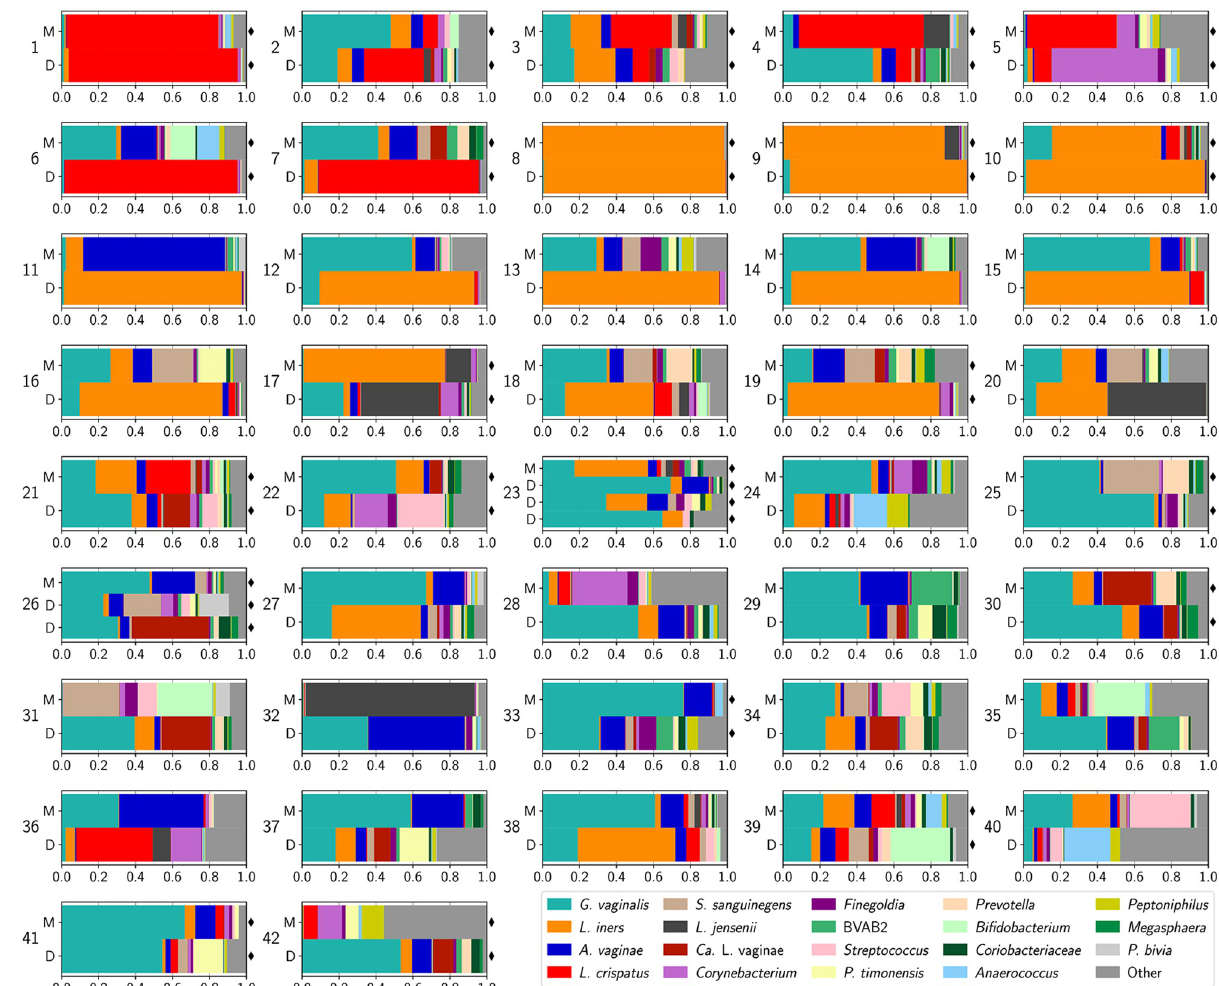
Fig 1. Taxonomic composition of the vaginal microbiota of reproductive age mothers and daughters. Stacked bars represent the relative abundances of individual bacterial phylotypes. Each plot displays the profiles for members belonging to the same family (M-Mother, D-Daughter). Two families (23,27) had 2 and 3 daughters, respectively. Samples denoted with black diamonds were selected for shotgun metagenomic